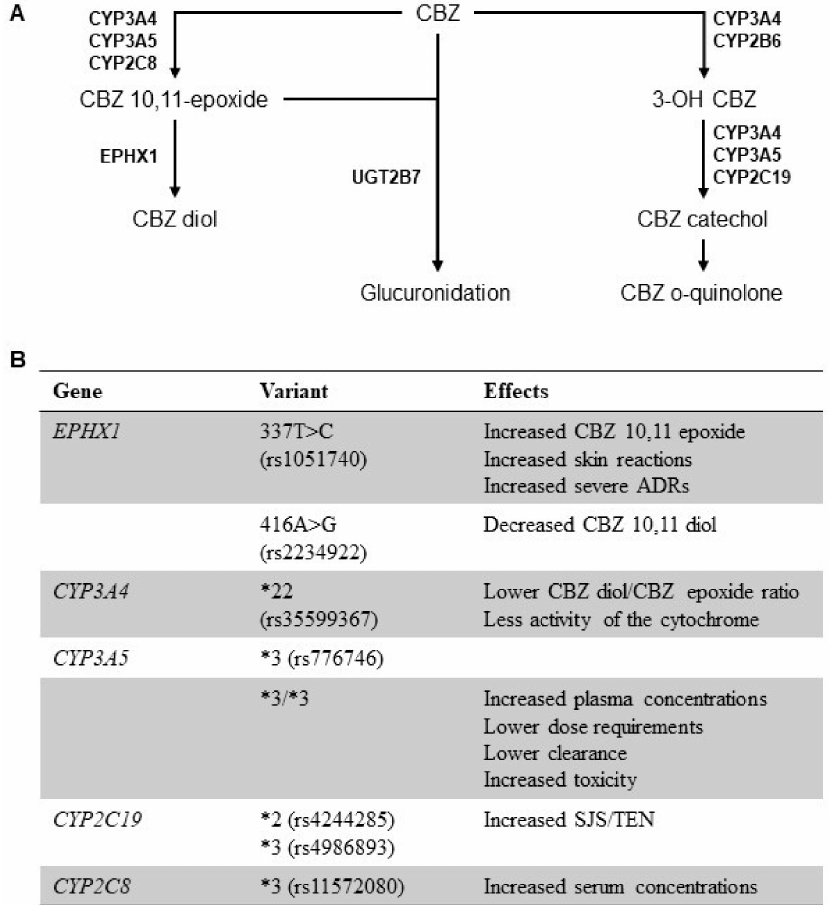
Figure 1. Pharmacokinetics (PK) and pharmacogenomics of carbamazepine (CBZ). ( A ) Liver metabolism of CBZ by cytochrome P450 (CYP) enzymes, epoxide hydrolase 1 ( EPXH1 ), and UDP- glucuronosyltransferase (UGT) and relative metabolites. ( B ) Genetic polymorphisms in genes in- volved in CBZ metabolism and their effects on PK of the drug. Abbreviations. (*) allele nomenclature; ADR, adverse drug reactions; SJS/TEN, Steven-Johnson syndrome/toxic epidermal